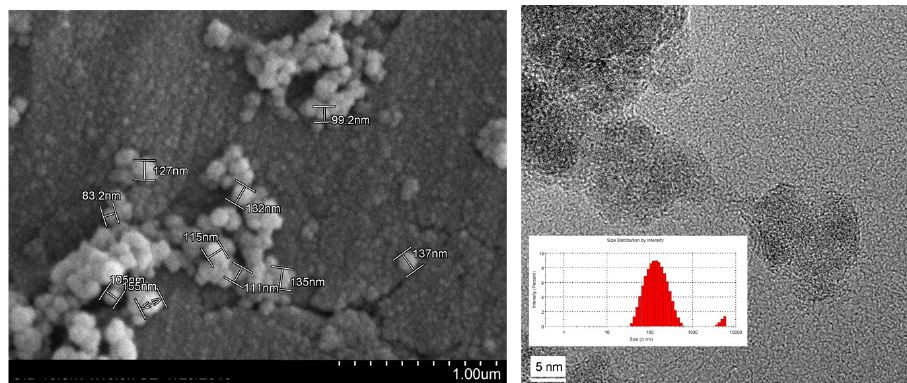
Figure 3. TEM micrographs and histogram showing the morphology and particle size distribution of magnetic nanoparticles covered by phytate groups (Phy@Fe 3 O 4 ).